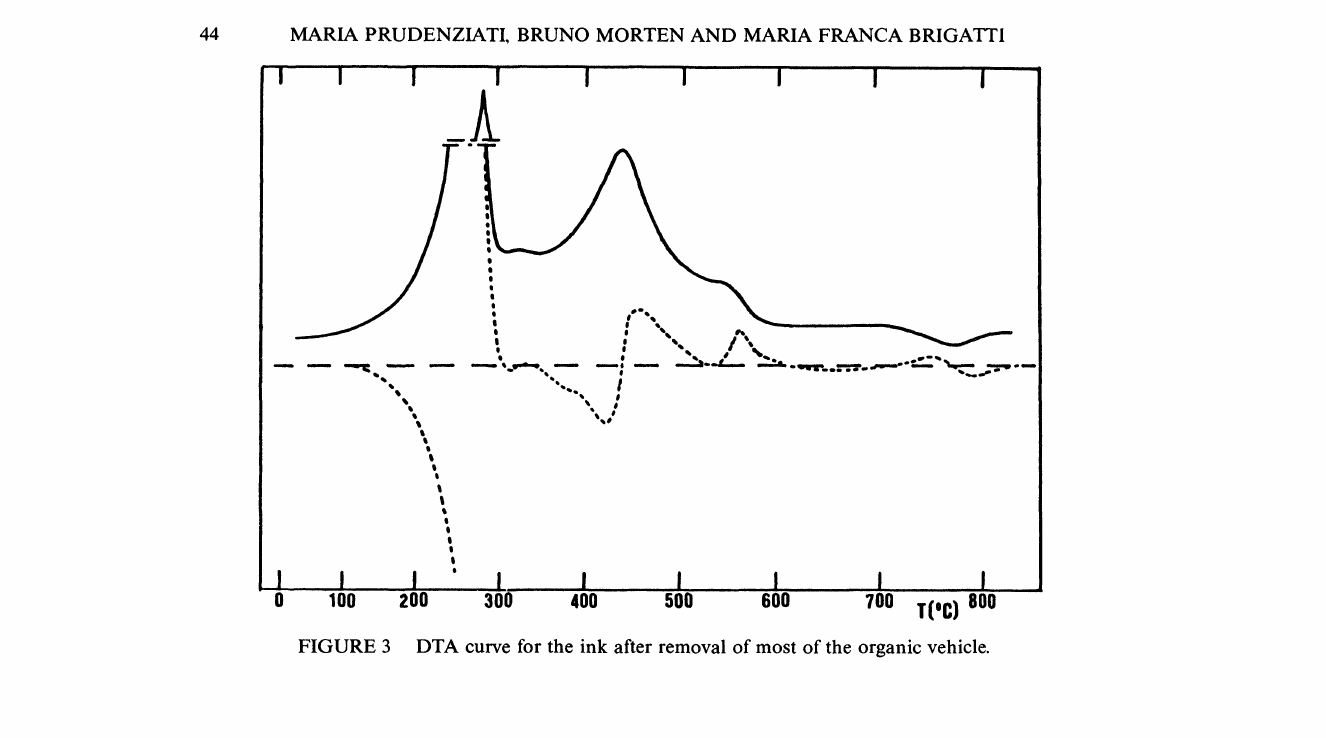
_1 0 FIGURE 3 DTA cue for the ink after removal of most of the organic vehicle.